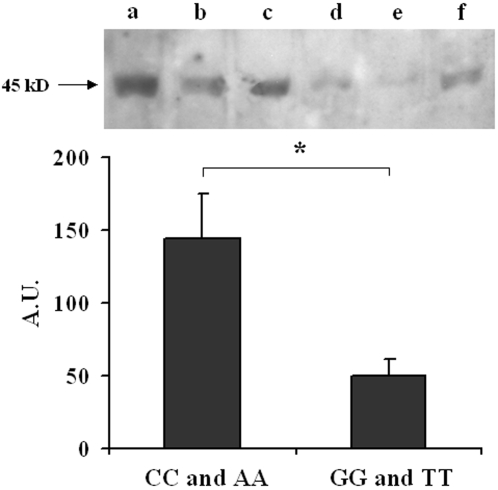
MMP16 immunoblots of tracheal aspirate supernatants from infants with the MMP16 AA-CC (lanes a–c) and GG-TT (lanes d–f) genotypes.Upper: a 45-kDa band was clearly identified in AA-CC infants but was barely visible in GG-TT infants. Lower: densitometric analysis (arbitrary units [A.U.]) in 9 AA-CC infants and 8 GG-TT infants, showing a significant difference in the MMP16 level (Mann Whitney p<0.02).